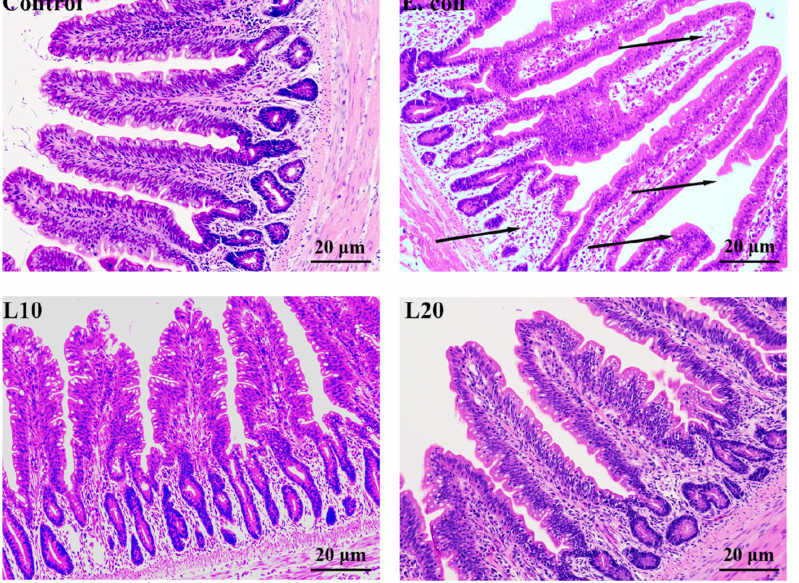
Figure 2. Effect of luteolin on pathological changes of the ileum tissues in chicks. Hematoxylin and eosin (HE) staining are shown (200 × ). The black arrows manifest the location of the